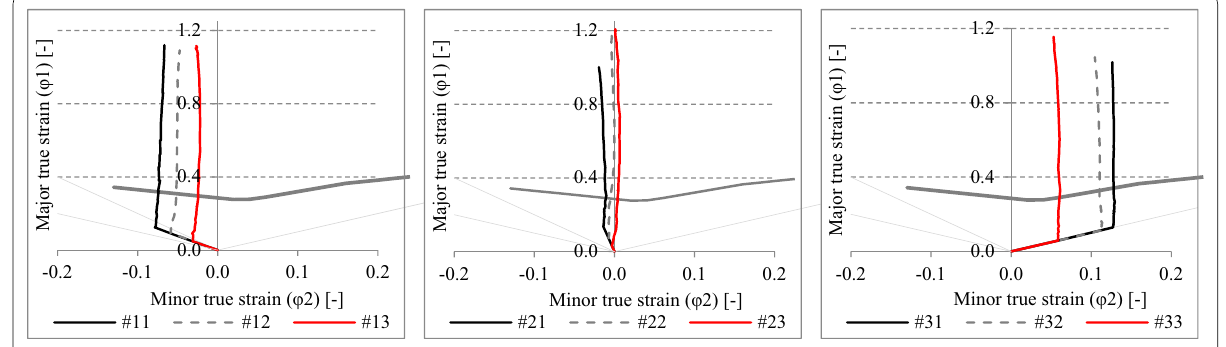
Figure 16 Forming paths (simulated) using the depth stop criteria